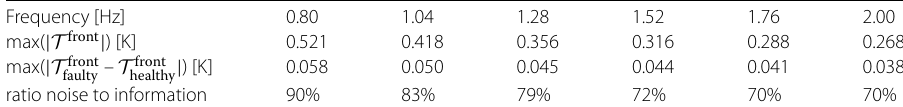
Table 1 Comparative between the amount of information and added noise. For six linearly-spaced frequencies between 0.8 and 2 Hz we present in the first row the maximum amplitude of a thermogram, on the second row the maximum amplitude of the difference between the thermogram of a faulty plate and the one corresponding to a healthy one, that is the amount of useful information, and on the last row the quotient between the added noise and that amount of information. For the considered frequency range, this ratio decreases as we increase the frequency Frequency [Hz] 0.80 1.04